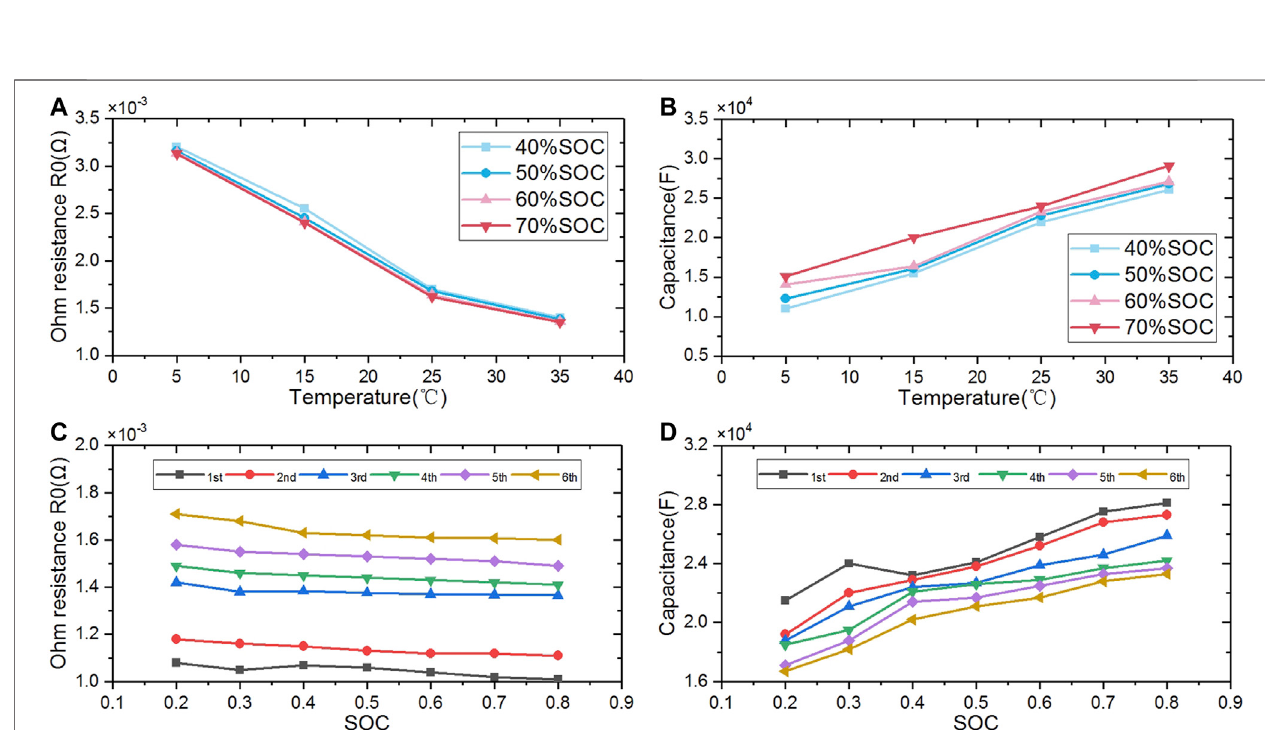
FIGURE7|(A) Thedisturbanceoftemperaturetoohmicresistance R 0 underdifferentSOCs. (B) Thedisturbanceoftemperaturetocapacitance C d underdifferent SOCs. (C) The disturbance of SOC to ohmic resistance R 0 at different life stages. (D) The disturbance of SOC to capacitance C d at different life stages.